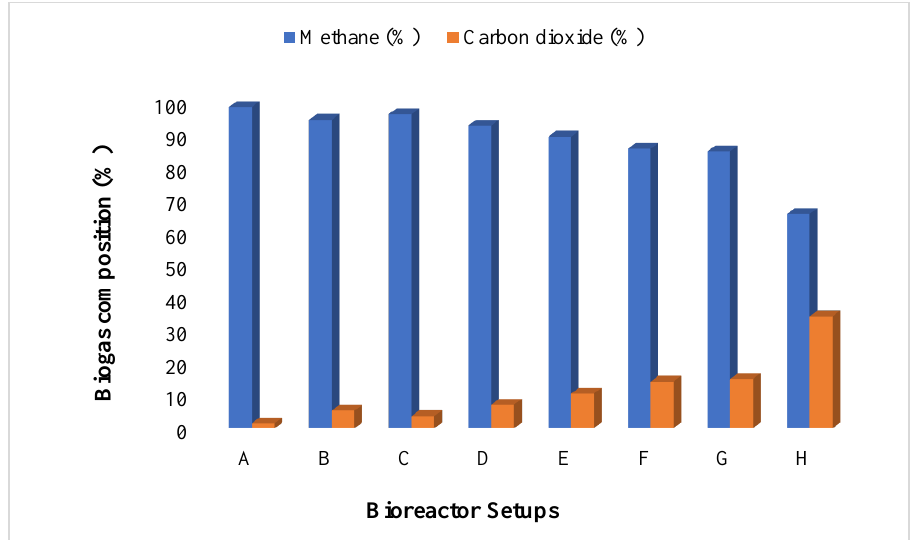
Figure 4. Biogas composition for bioreactors A (mF), B (NmF), C (CmF), D (TmF), E (ChTmF), F (CTmF), G (ATmF), and H (no MNM) of MNM loading of 1.5 g at 35 °C for 30 HRT.